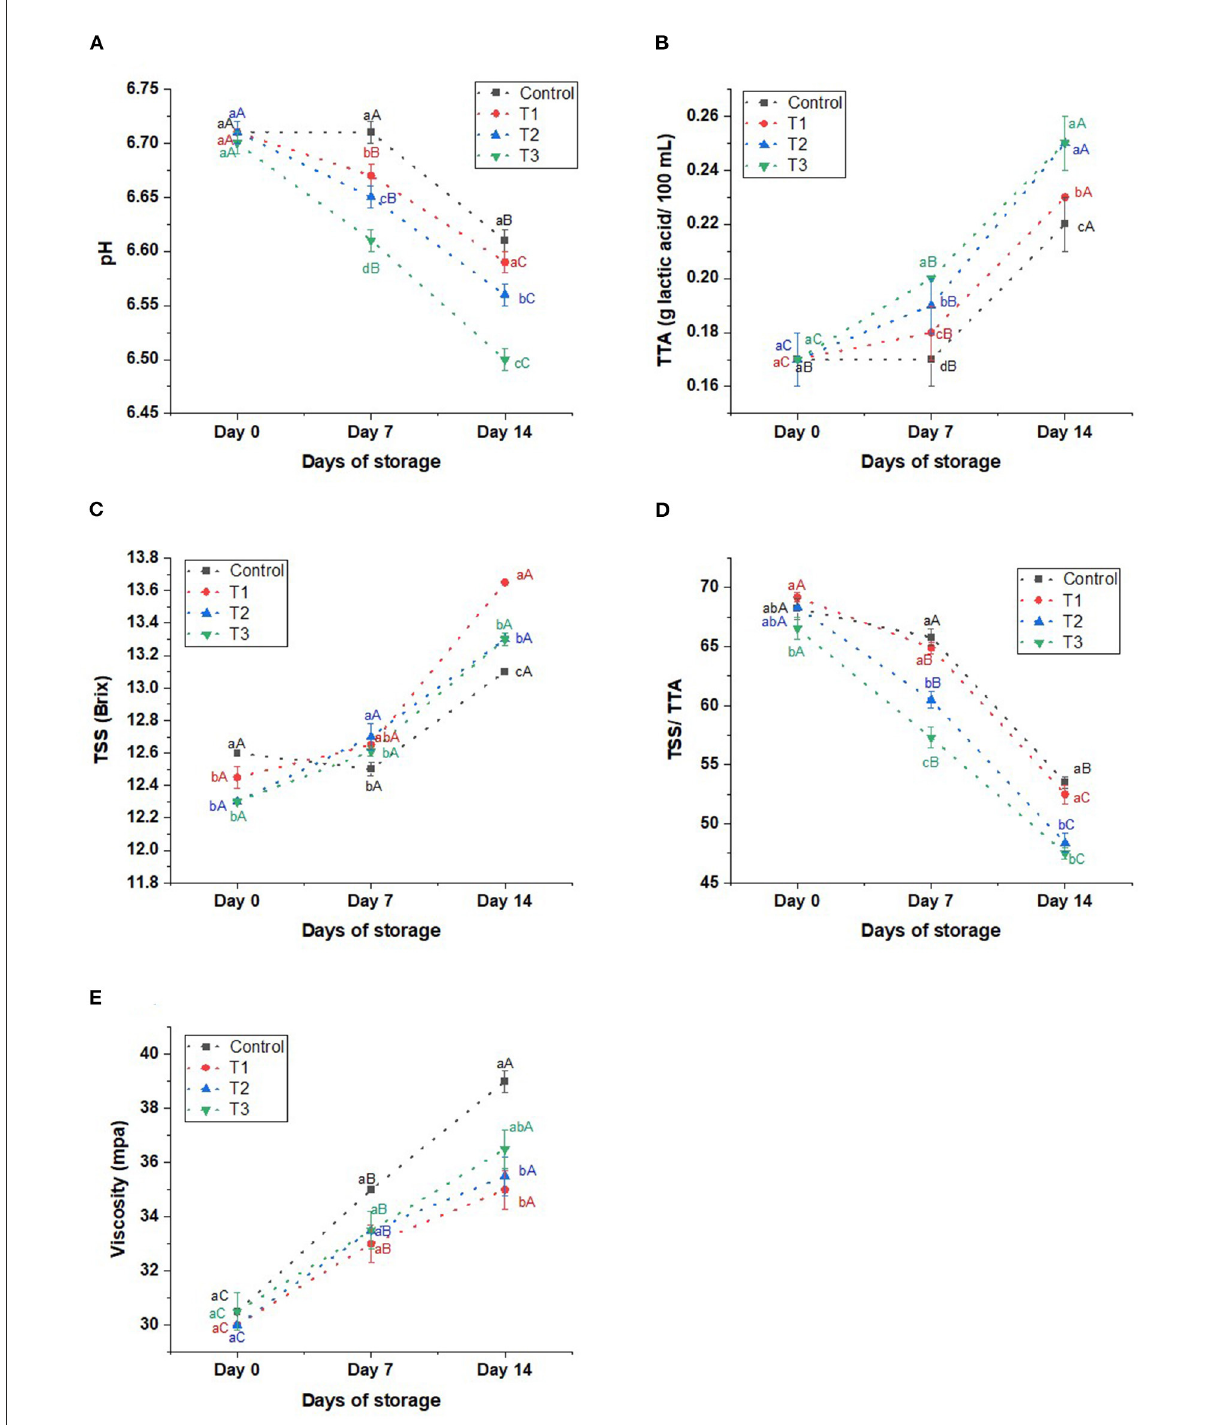
FIGURE2 (A) pH, (B) total titratable acidity (TTA) in g lactic acid/100mL, (C) total soluble solids (TSS) in Brix (D) TSSITAA ratio, and (E) viscosity in mpa of control beverage and beverages enriched with beetroot peel extracts at different concentrations. Means with different lowercase letters (a–d) on the same storage day are statistically different ( p < 0.05). Means with different uppercase letters (A–C) for each treatment during the different storage days are statistically different ( p <